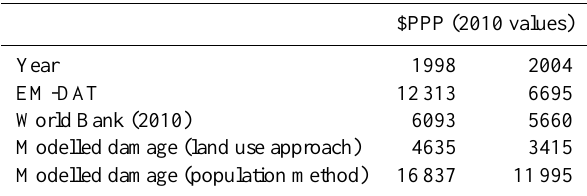
Table 3. Comparison of observed and simulated damages in 1998 and 2004. Note: for the 1998 flood we used the modelled results for the 30yr return period inundation when in reality the return period was in the order of 30–70yr; and for the 2004 flood we used the modelled results for the 15yr return period inundation when in re- ality the return period was in the order of 20yr. All values are in $PPP2010. $PPP (2010 values) 1998 2004 EM-DAT 12313 6695 World Bank (2010) 6093 5660 Modelled damage (land use approach) 4635 3415 Modelled damage (population